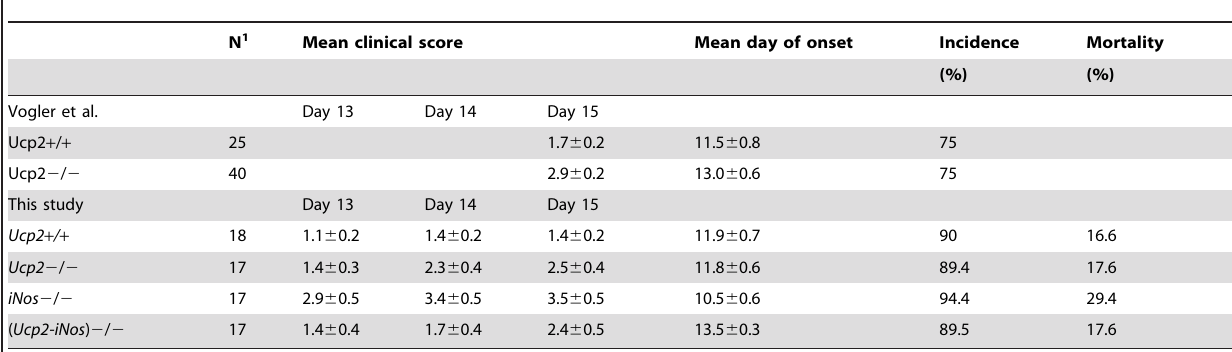
Table 1. Clinical parameters of the mice during Experimental Autoimmune Encephalomyelitis.